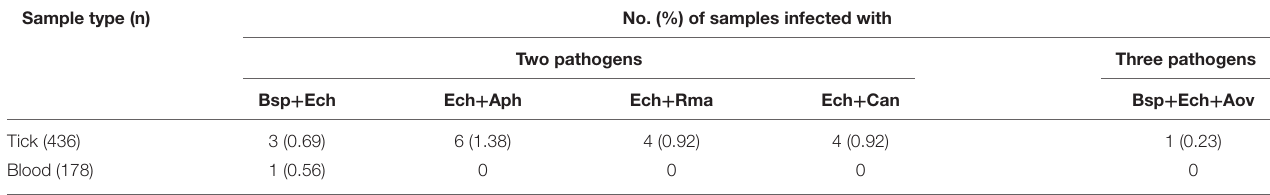
TABLE 2 | Co-infection of pathogens in ticks and blood of pet dogs in this study. Sample type (n) No. (%) of samples infected with Two pathogens Three pathogens